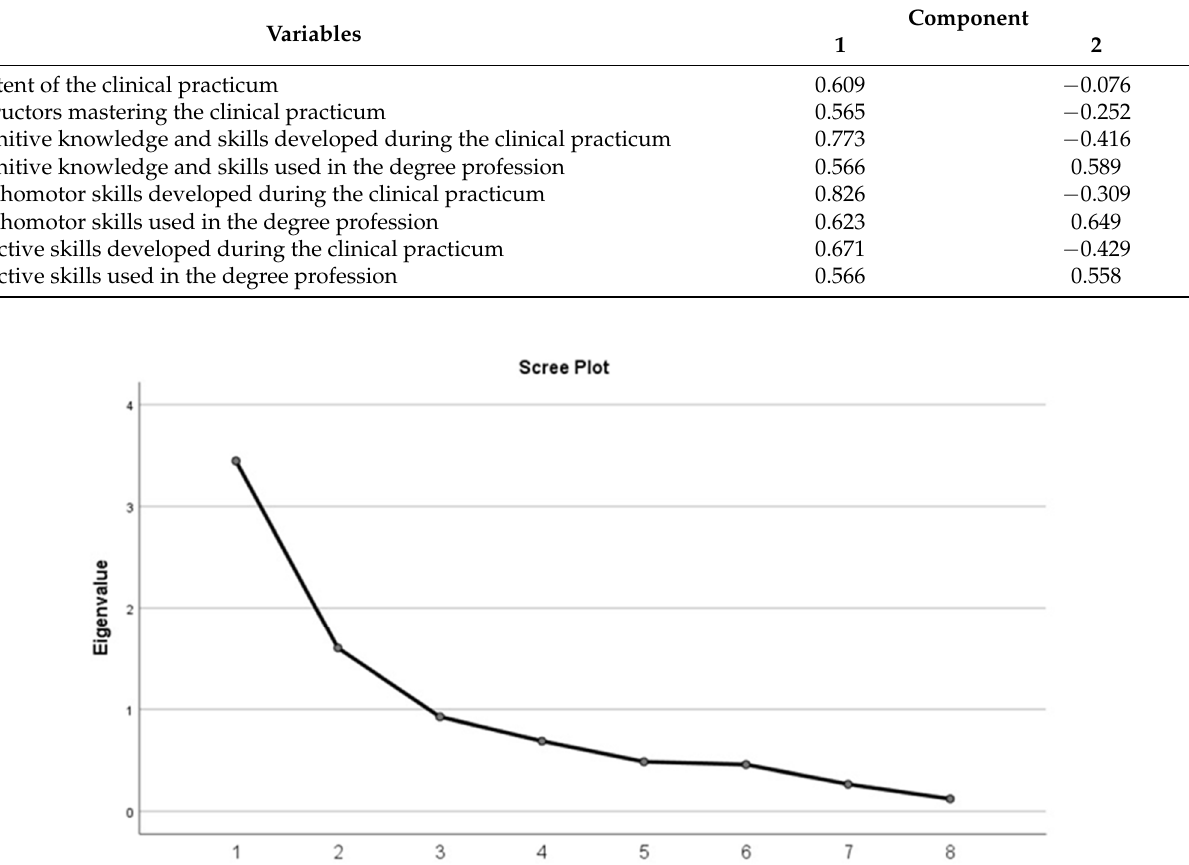
Table 3. Principal component analysis of the questionnaire variables matrix. All variables were positive in the first component, and only 4, 6 and 8 were positive in the second component.